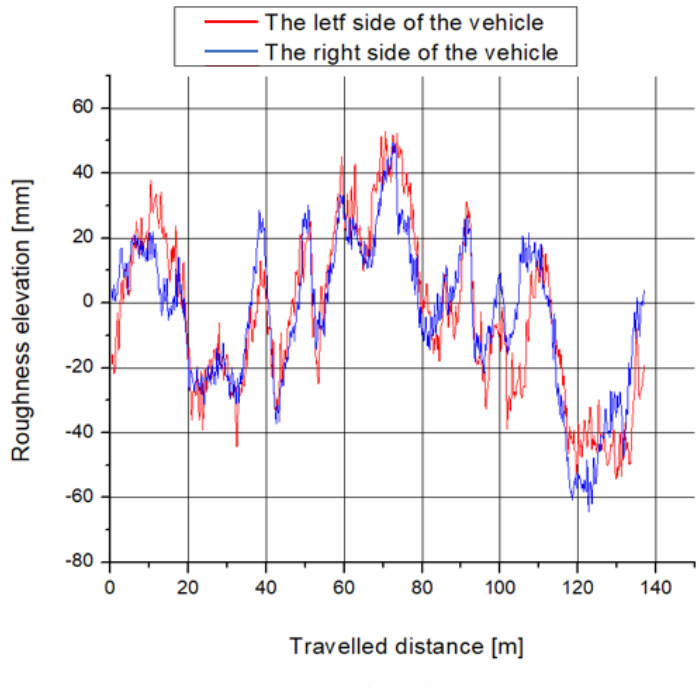
Figure 7. Road roughness.